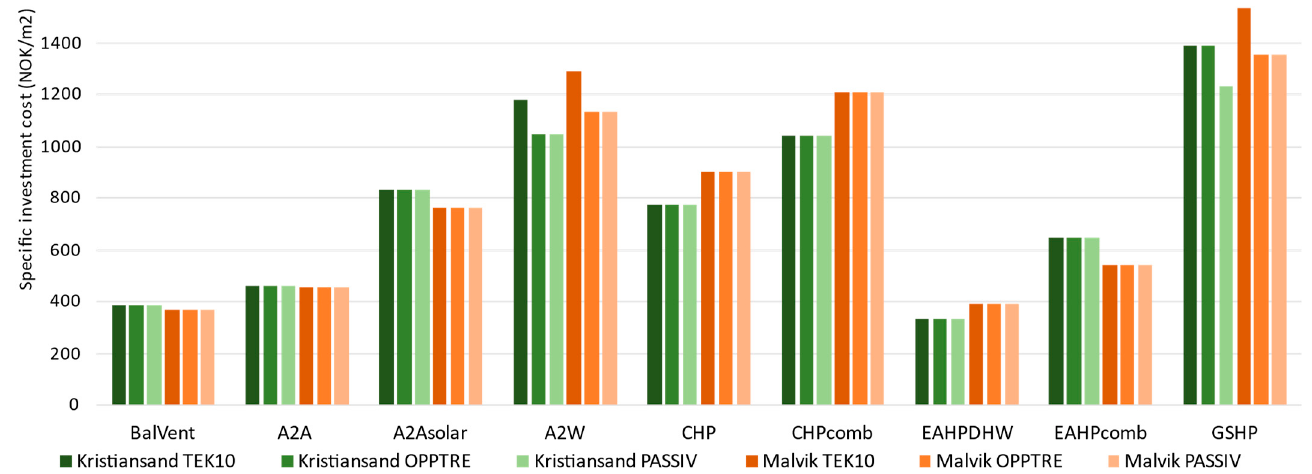
Figure 14. Total specific investment costs for HVAC combinations, when assuming hydronic dis- tribution system already installed.